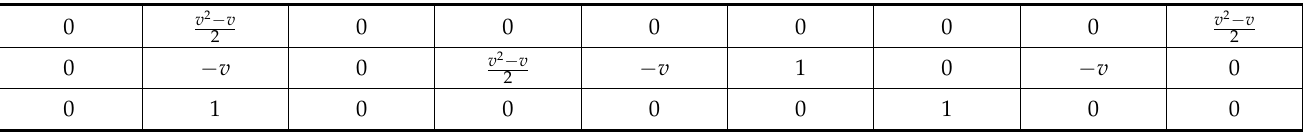
Table 1. G-L fractional differential